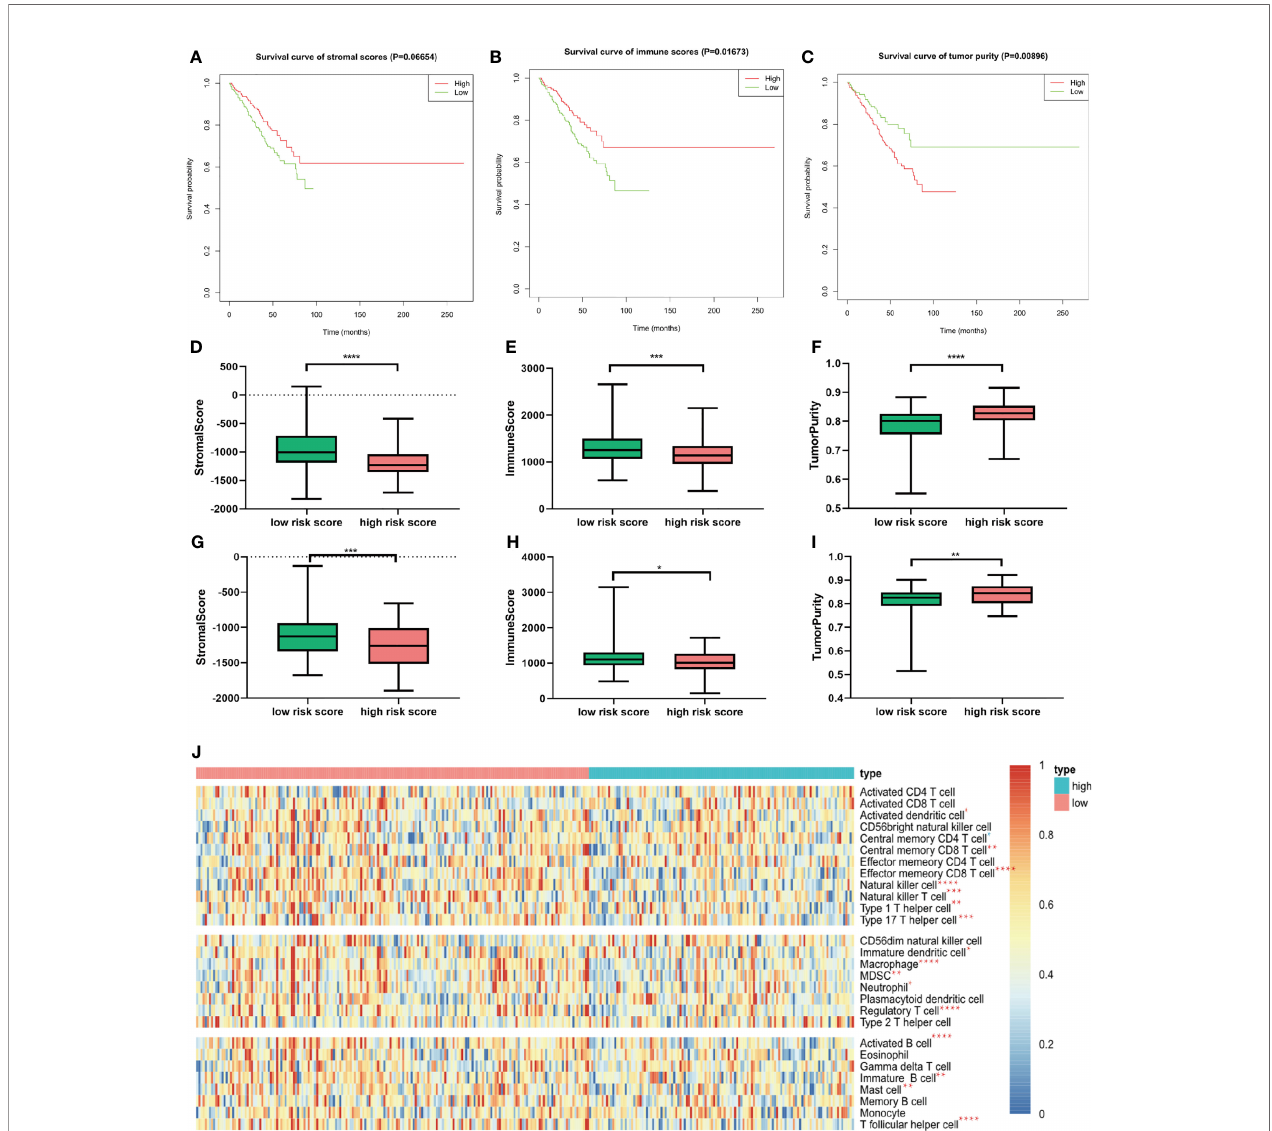
FIGURE 7 | Relationship between immune in fi ltration level and m6A prognostic risk score. (A – C) Kaplan – Meier survival analysis upon stromal score (A) , immune score (B) , and tumor purity (C) in GSE24080. (D – F) The distribution of stromal score (D) , immune score (E) , and tumor purity (F) upon different risk score in GSE24080. (G – I) The distribution of stromal score (D) , immune score (E) , and tumor purity (F) upon different risk score of the validation cohort GSE9782. (J) Twenty-eight immune-related gene sets were performed for ssGSEA. Seventeen immune cell gene sets were signi fi cantly different between patients with high and low risk score. Red star represents higher enrichment score; blue star represents lower enrichment score compared to high-risk MM patients. * p < 0.05, ** p < 0.01, *** p < 0.001, **** p <